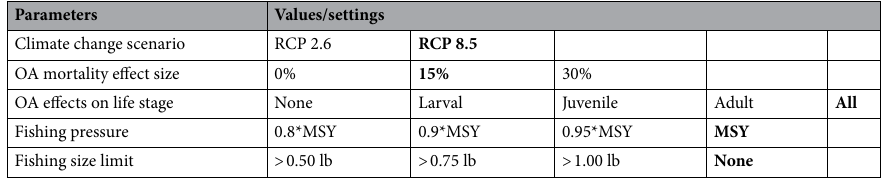
Table 2. Scenario settings explored with model projections. *All combinations of parameter values were explored. Bolded cells are the values that are kept constant when exploring each parameter—the ‘null’